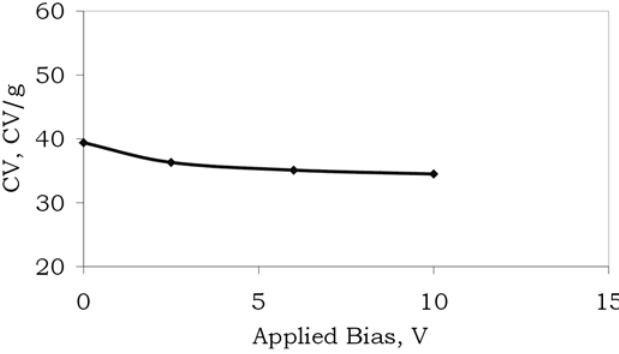
FIGURE 7 Bias dependency of NbO anodes after 20 exposure to 300 (cid:4) C = 10